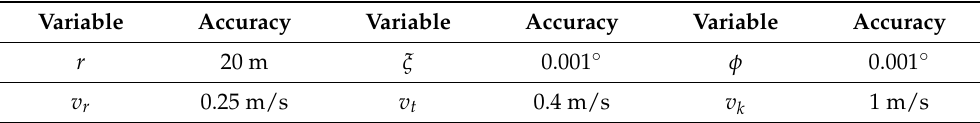
Table 2. Estimation